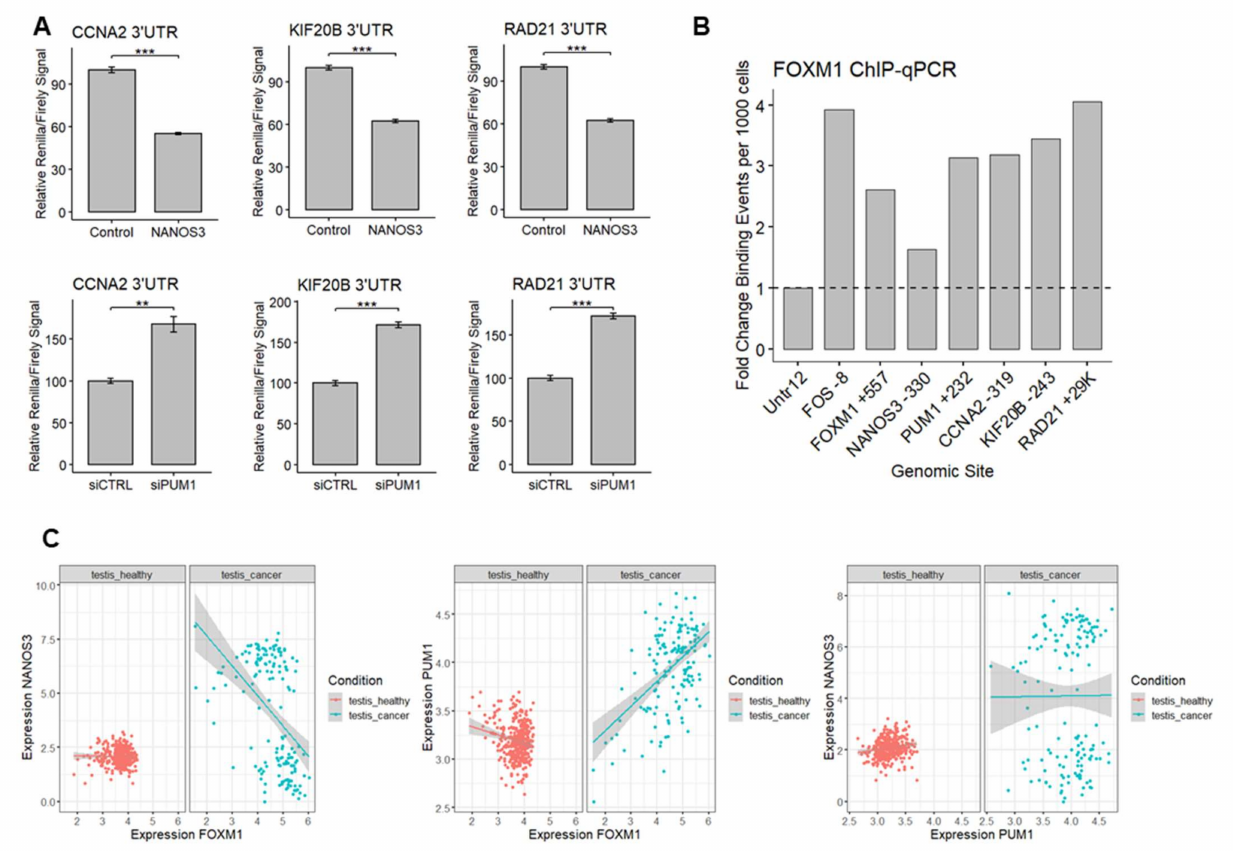
Figure 6. The NANOS3–PUM1–FOXM1 axis coordinates the expression of the cell cycle genes. ( A ) Dual luciferase assay to measure Renilla/Firefly ratio upon PUM1 knockdown and NANOS3 overexpression using 3 (cid:48) UTR of CCNA2 , KIF20B , and RAD21 in the downstream of Renilla ORF. ( B ) Relative fold change of FOXM1 binding events per 1000 cells for the promoter region of the target genes measured by ChIP-qPCR. ( C ) Differential correlation analysis of NANOS3 , PUM1 , and FOXM1 in publicly available healthy testis (GTEx) and testicular cancer datasets (TCGA). Each dot represents a single GTEx or TCGA dataset. Expression values are transformed as log(expression +1). Standard error is visualized as error bars. ** = p -value ≤ 0.01, *** = p -value ≤